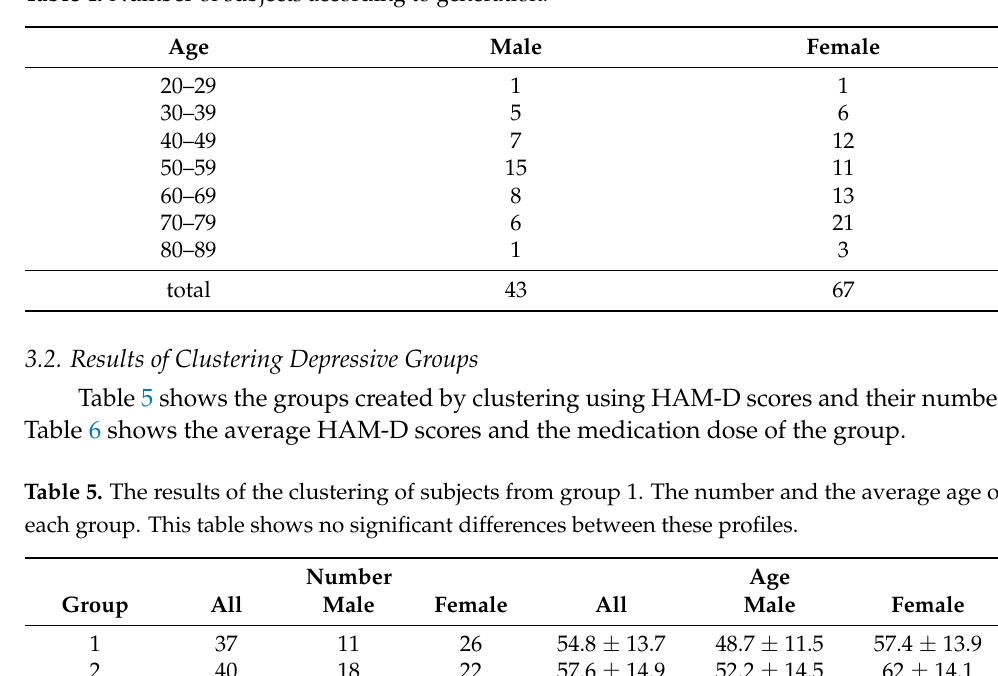
Table 4. Number of subjects according to generation.